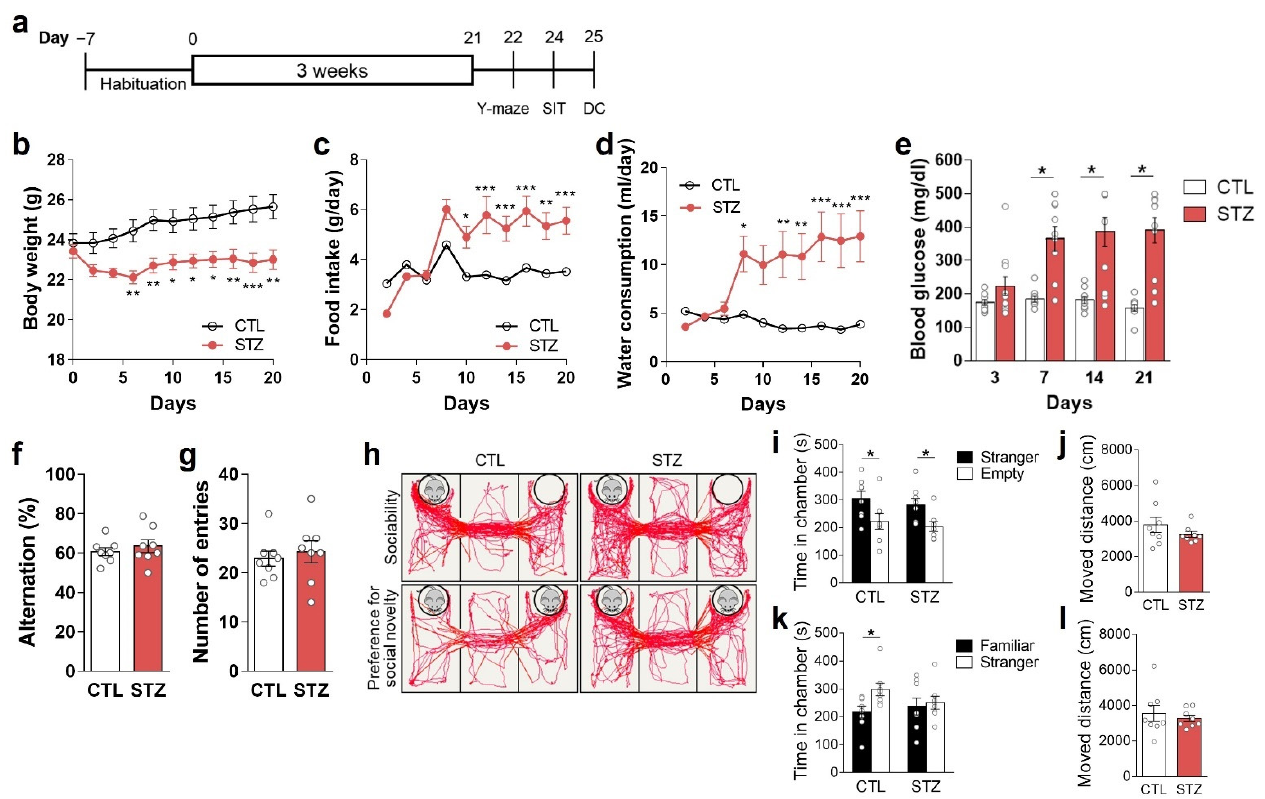
Figure 1. Streptozotocin (STZ)-induced hyperglycemia caused anhedonic behaviors. ( a – e ) Construc- tion of an STZ-induced hyperglycemia model: ( a ) experimental design and changes in ( b ) body weight; ( c ) food intake; ( d ) water consumption; and ( e ) blood glucose levels of control (CTL) and STZ-injected (STZ) mice over 3 weeks. ( f , g ) Y-maze results: ( f ) spontaneous alternations and ( g ) total number of entries into the 3 arms of the Y-maze apparatus. ( h – l ) Hyperglycemia-induced anhedonic behaviors: ( h ) representative movement-tracking images for social interaction tests, chamber explo- ration time, and moved distance in the sociability test, ( i , j ) and the preference for social novelty test ( k , l ). Data are presented as mean ± SEM. ( b – d ) * p < 0.05, ** p < 0.01, *** p < 0.001 compared with the CTL group according to two-way ANOVA with Tukey’s post-hoc tests. ( e , i , k ) * p < 0.05 between indicated groups according to Student’s t -test. n = 8/group. DC, decapitation; SIT, social interaction test.